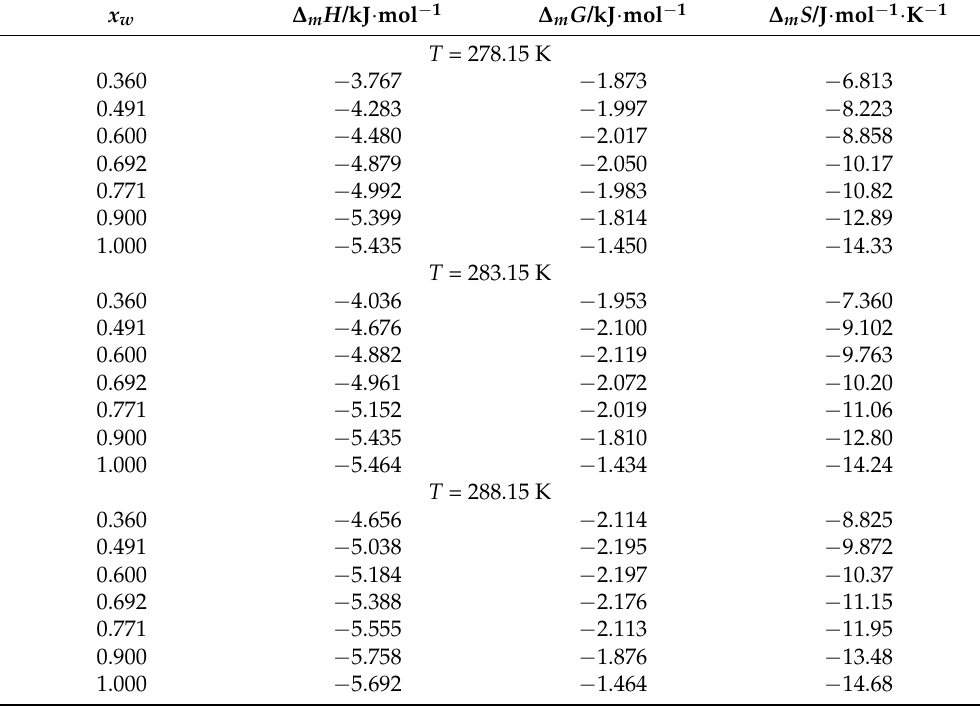
Table 10. Mixing thermodynamic properties of 1,5-pentanediamine adipate dihydrate in water + methanol mixtures a,b